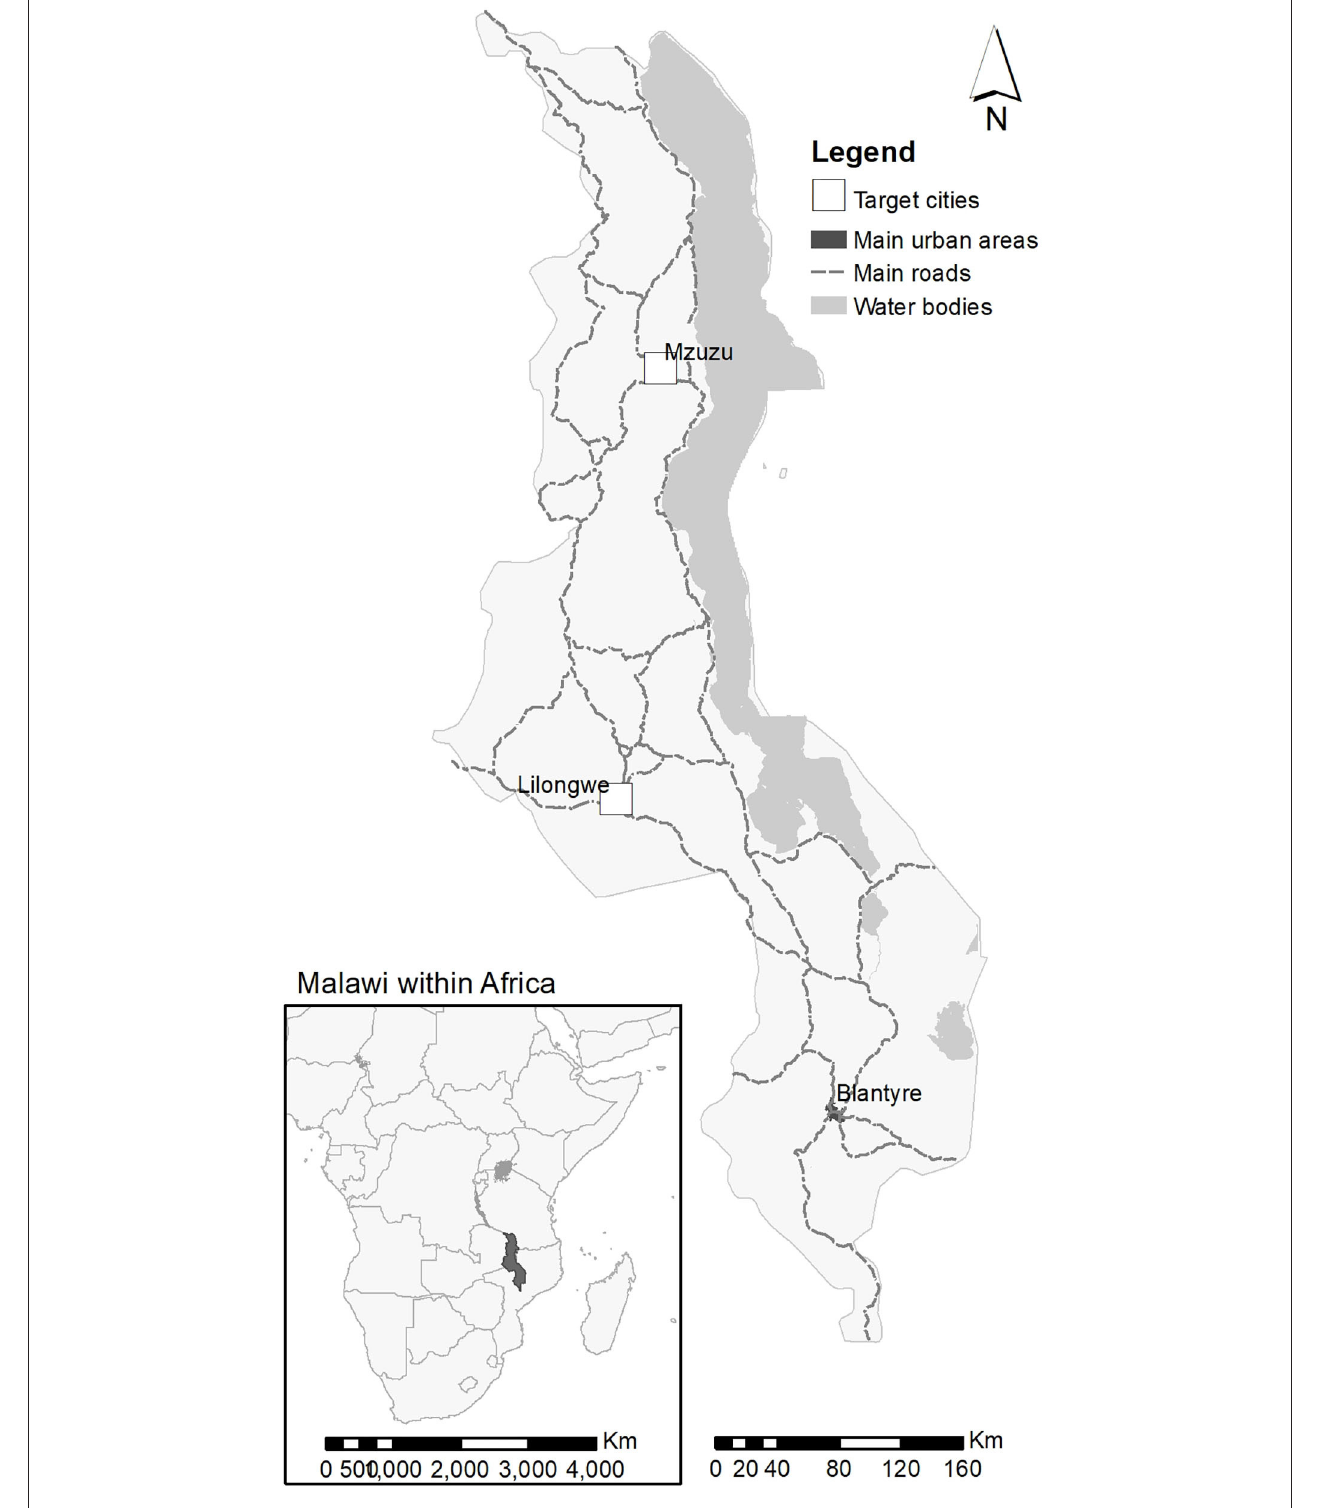
FIGURE 1 | The location of the two target cities, Mzuzu and Lilongwe within Malawi. Inset shows the location of Malawi in southern Africa.